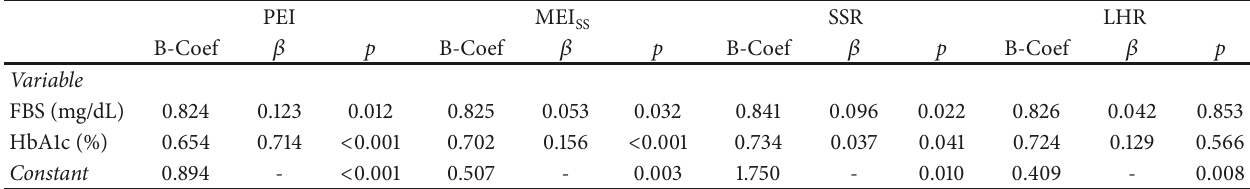
Table 4: Multivariate linear regression analysis for percussion entropy index (PEI), LHR, and SSR for all subjects (n =